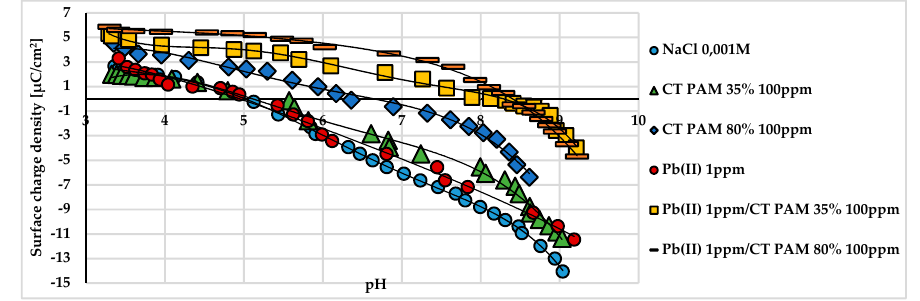
Figure 1. Surface charge density of examined adsorption systems as a function of solution